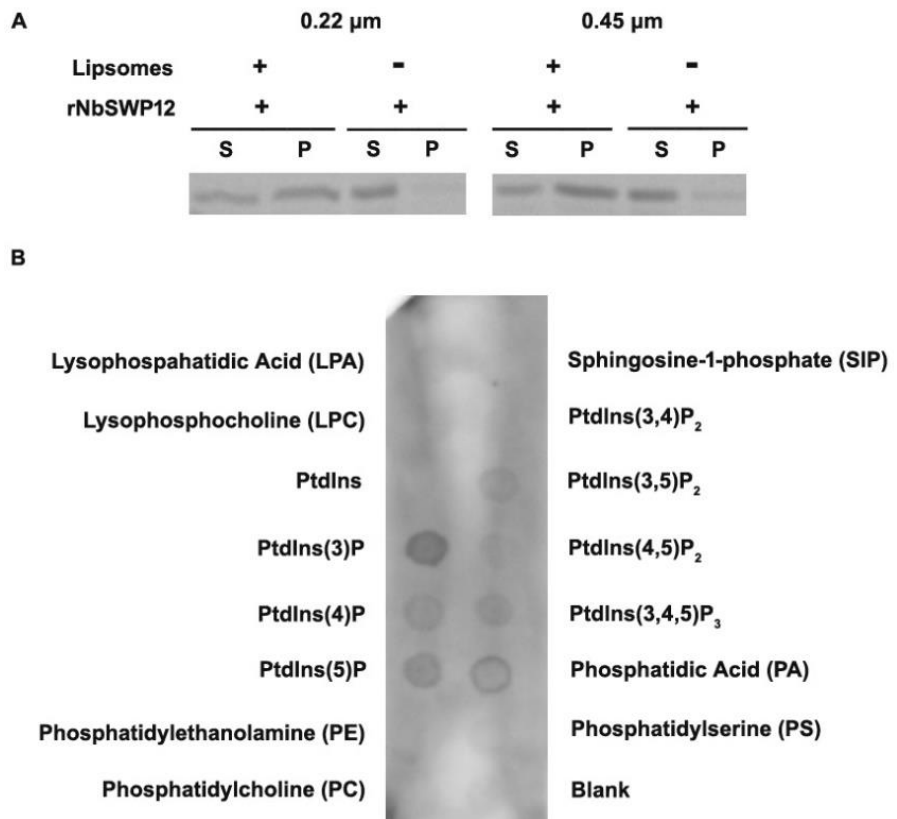
Figure 3. NbSWP12 interacts with phosphoinositide. ( A ) SDS-PAGE analysis of NbSWP12 and liposomes interaction; 0.05 µg/µL bacterial purified rNbSWP12 incubated with 1 μg/μL 0.22 µm or 0.45 µm Folch fraction derived liposomes in a cosedimentation assay. Supernatant (S) and precipitate (P) were loaded and separated on 12% SDS-PAGE. The results indicated that rNbSWP12 binds with lipids. ( B ) The affinity of rNbSWP12 for phospholipids was assessed using a protein-lipid overlay